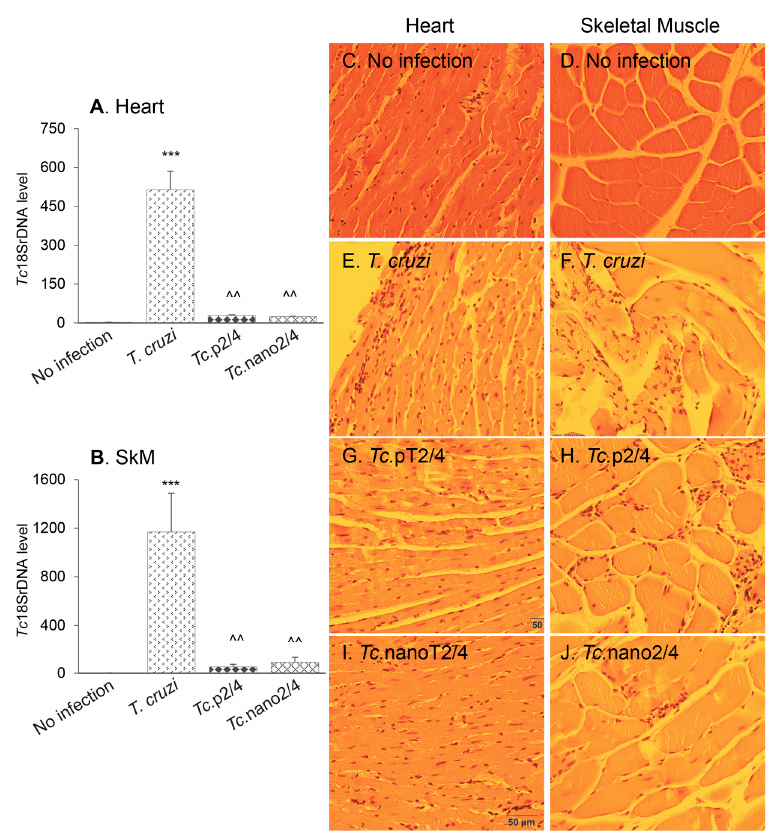
Figure 3. ( A , B ) Tissue parasite burden in Chagas mice ( ± nanotherapy). Mice were challenged